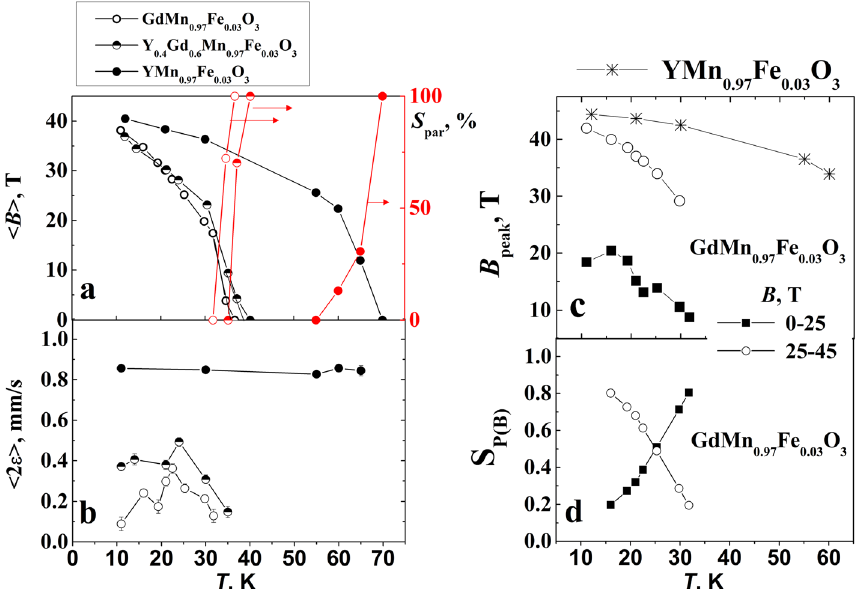
Figure 9. Dependence of average hyperfine field < B > (left), relative area of doublet S (right) ( a ), average quadrupole shift < 2ε> ( b ) for YMn 0.97 Fe 0.03 O 3 , Y 0.4 Gd 0.6 Mn 0.97 Fe 0.03 O 3 , and GdMn 0.97 Fe 0.03 O 3 on temperature. The peaks positions ( c ) and the relative area of hyperfine field distributions P( B ) (d) within 0–25 and 25–45 T regions on